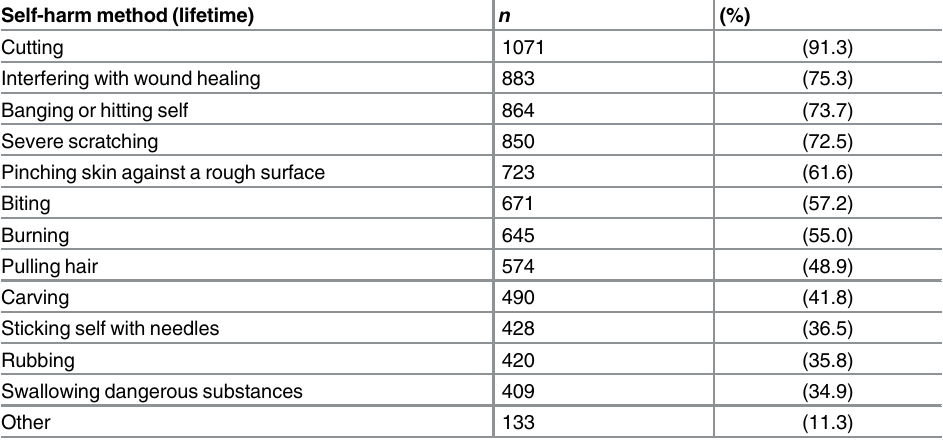
Table 2. Methods of self-harm reported by participants with a lifetime history of self-harm, n = 1173. Self-harm method